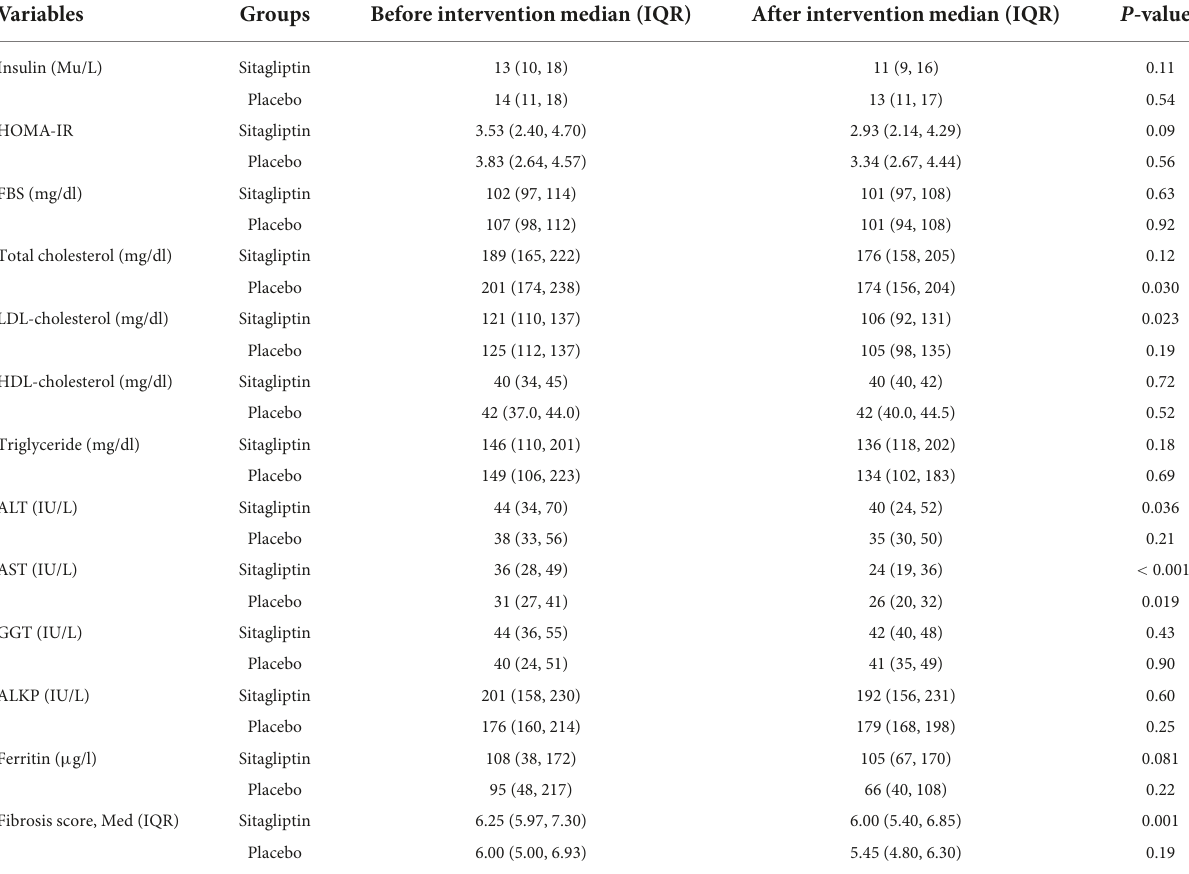
TABLE 2 Changes in fibrosis score and laboratory data in the sitagliptin group ( n = 44) and the placebo group ( n = 32) before and after the intervention. a Variables